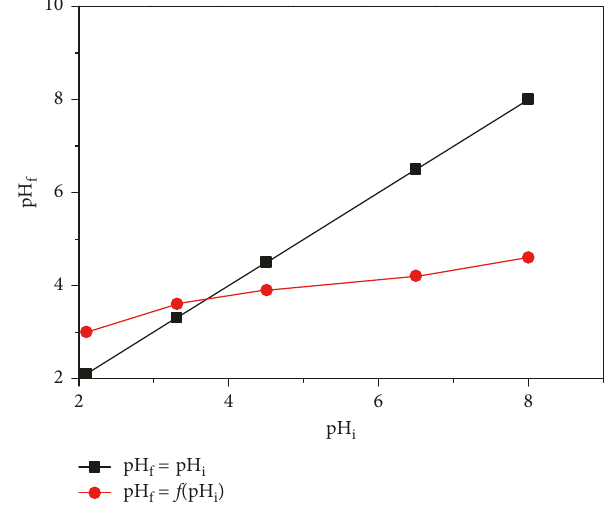
Figure 5: pH pzc of the activated carbon prepared at the optimal